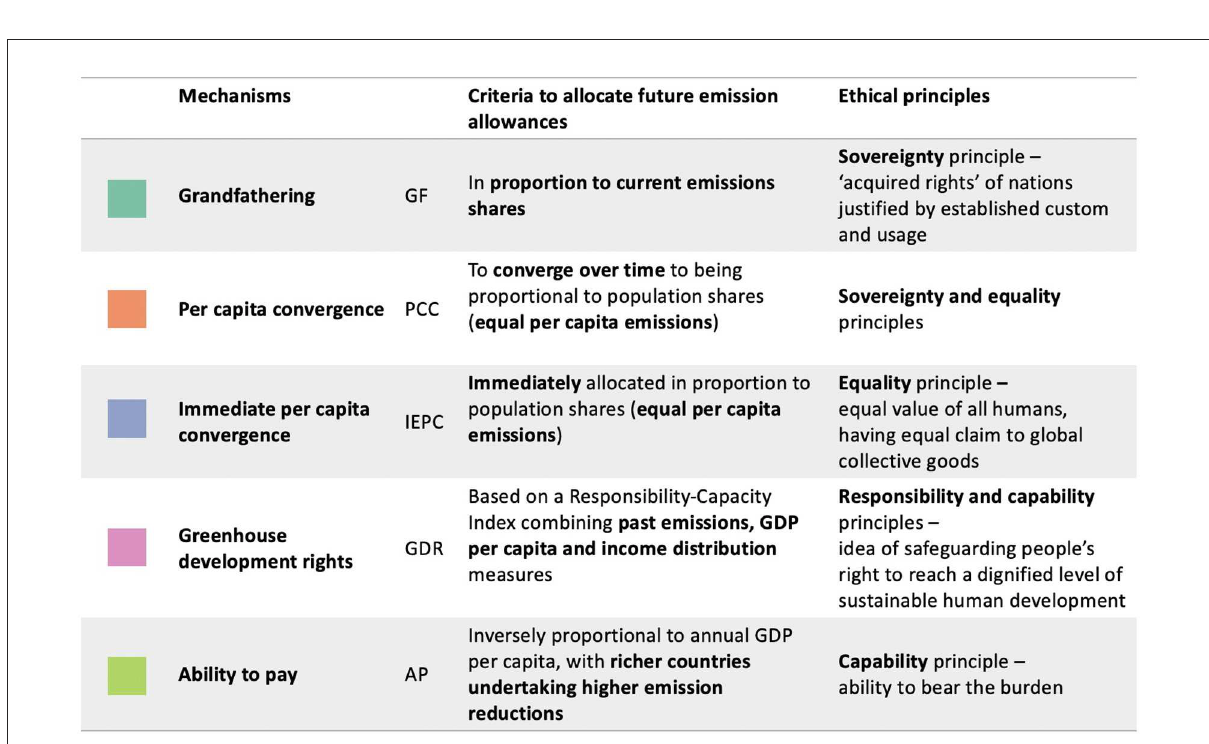
FIGURE4 Description of the selected climate mitigation effort sharing mechanism and the underlying ethical principles.